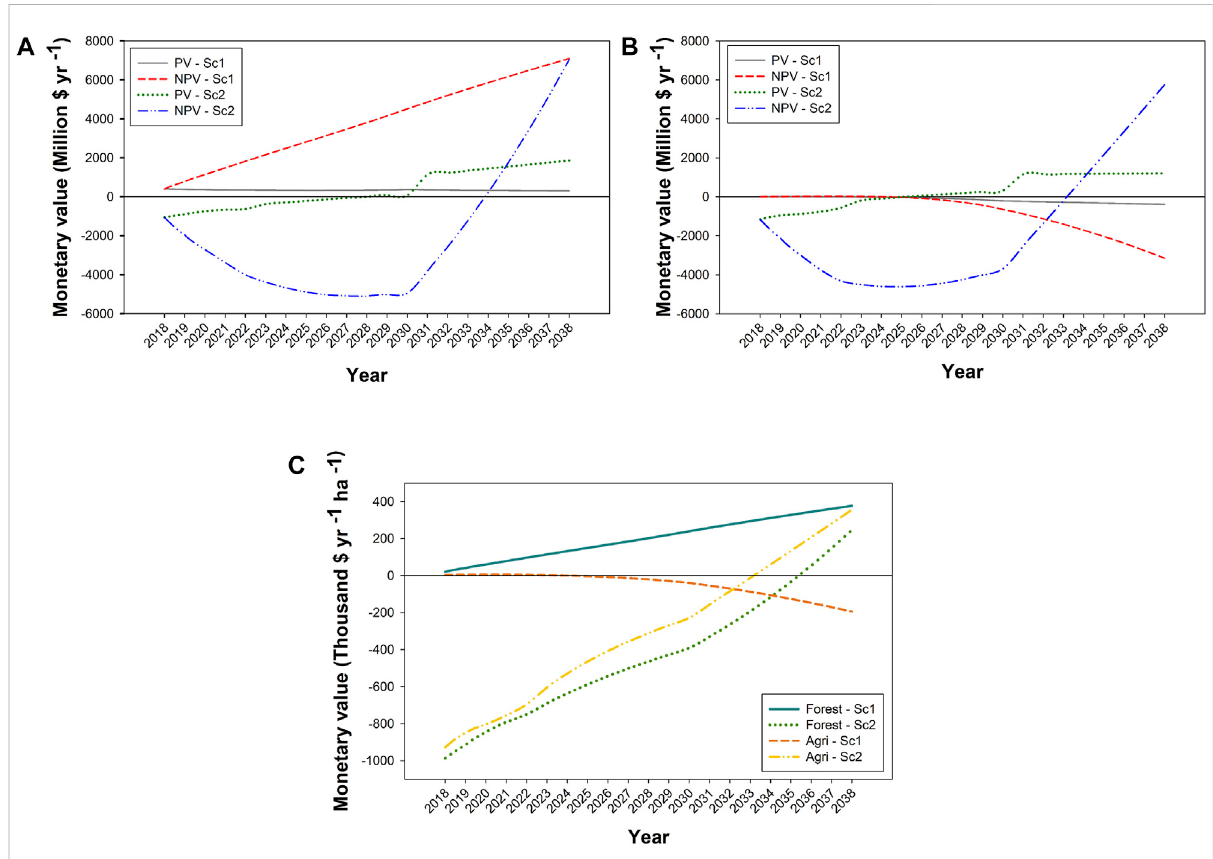
FIGURE 5 Comparison of NPV and cumulative NPV between scenarios in forest (A) and agricultural land (B) , and comparison of the cumulative net pro fi t per hectare for each scenario in forest and agricultural land (C) (PV: Present value, NPV: Net present value, SC: Scenario, Agri: Agricultural